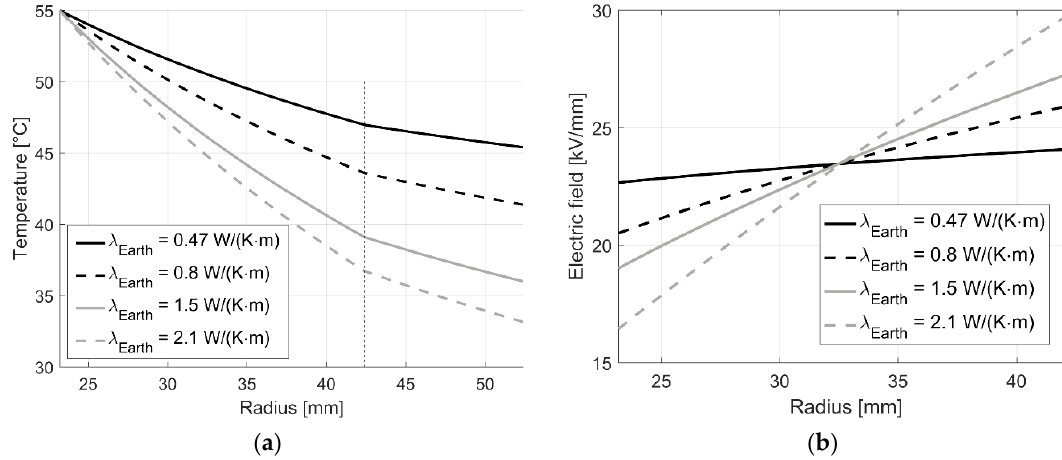
Figure 12. ( a ) Simulated temperature distribution inside a MI insulation. The vertical block dotted line is the interface between the insulation and the outer sheath; ( b ) stationary electric fields stress, resulting from the temperature distribution [51].